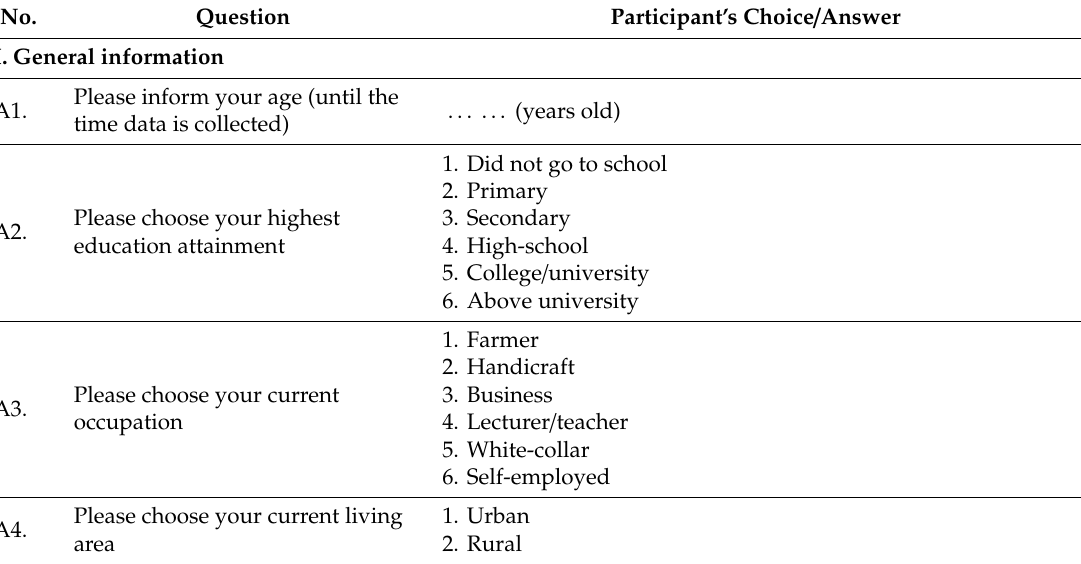
Table A1. Questionnaire to pregnant